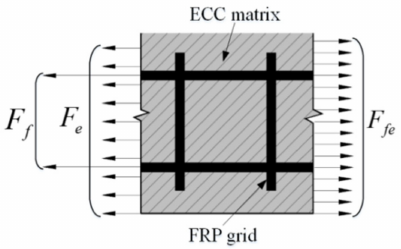
Figure 10. Cross-sectional force analysis of FRP grid-reinforced ECC composites.